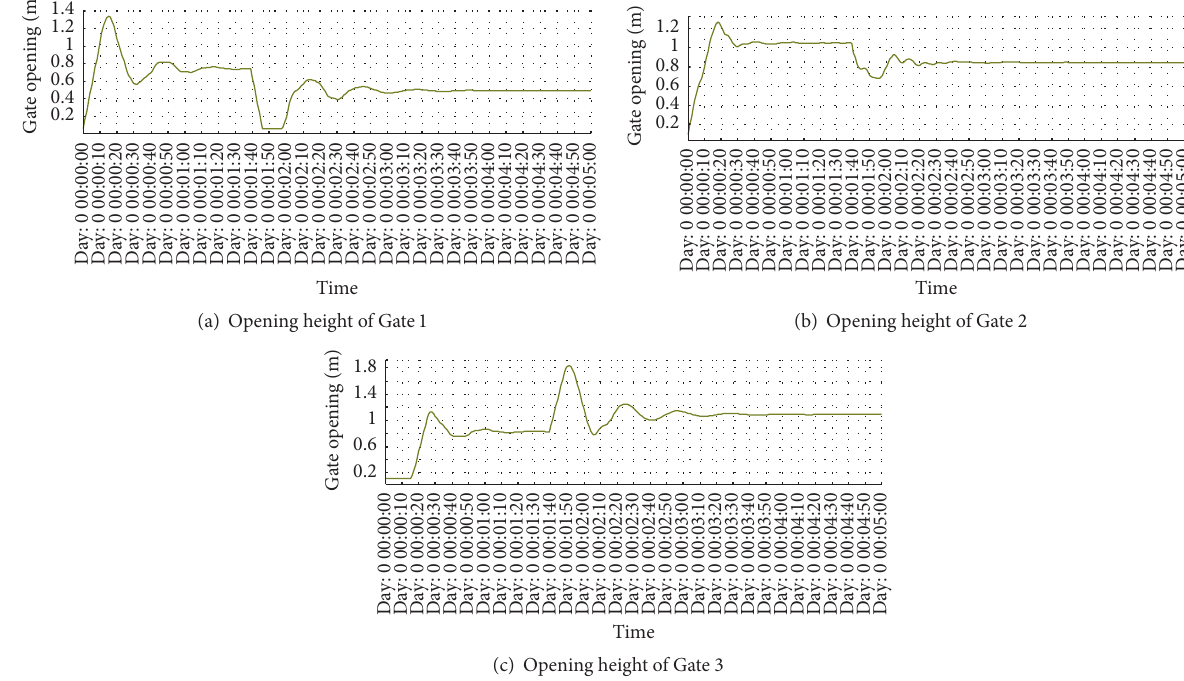
(c) Opening height of Gate 3 Figure 13: Evolutions of three gate opening heights with 𝑁 = 𝑀 = 60 .